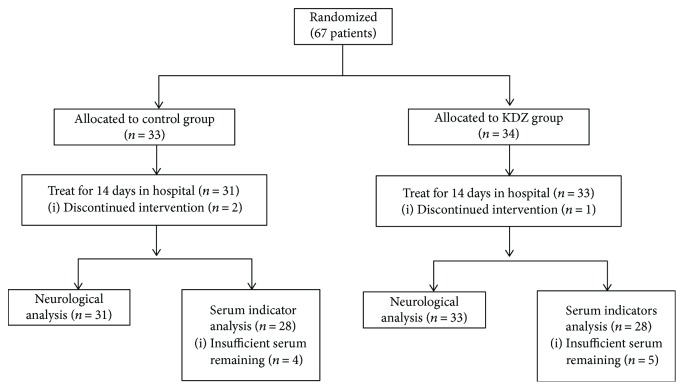
Patient flowchart.